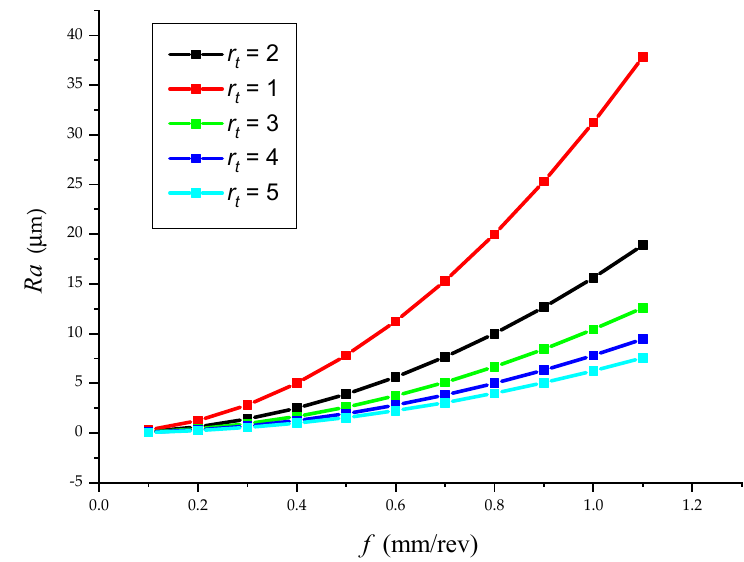
Figure 10. The e ff ect of blunting the tool edge r t on the surface roughness Ra = f ( f ). Figure 10. The effect of blunting the tool edge r t on the surface roughness Ra = f ( f ).